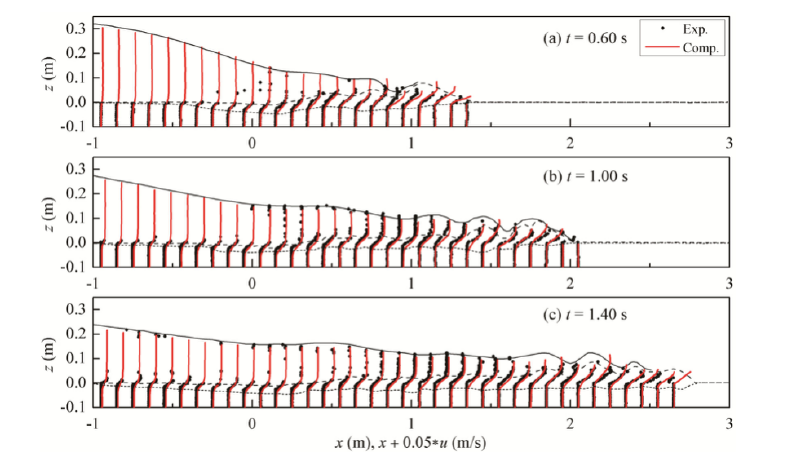
Figure 19. SPH simulations of dam-break flows impacting the riverbed